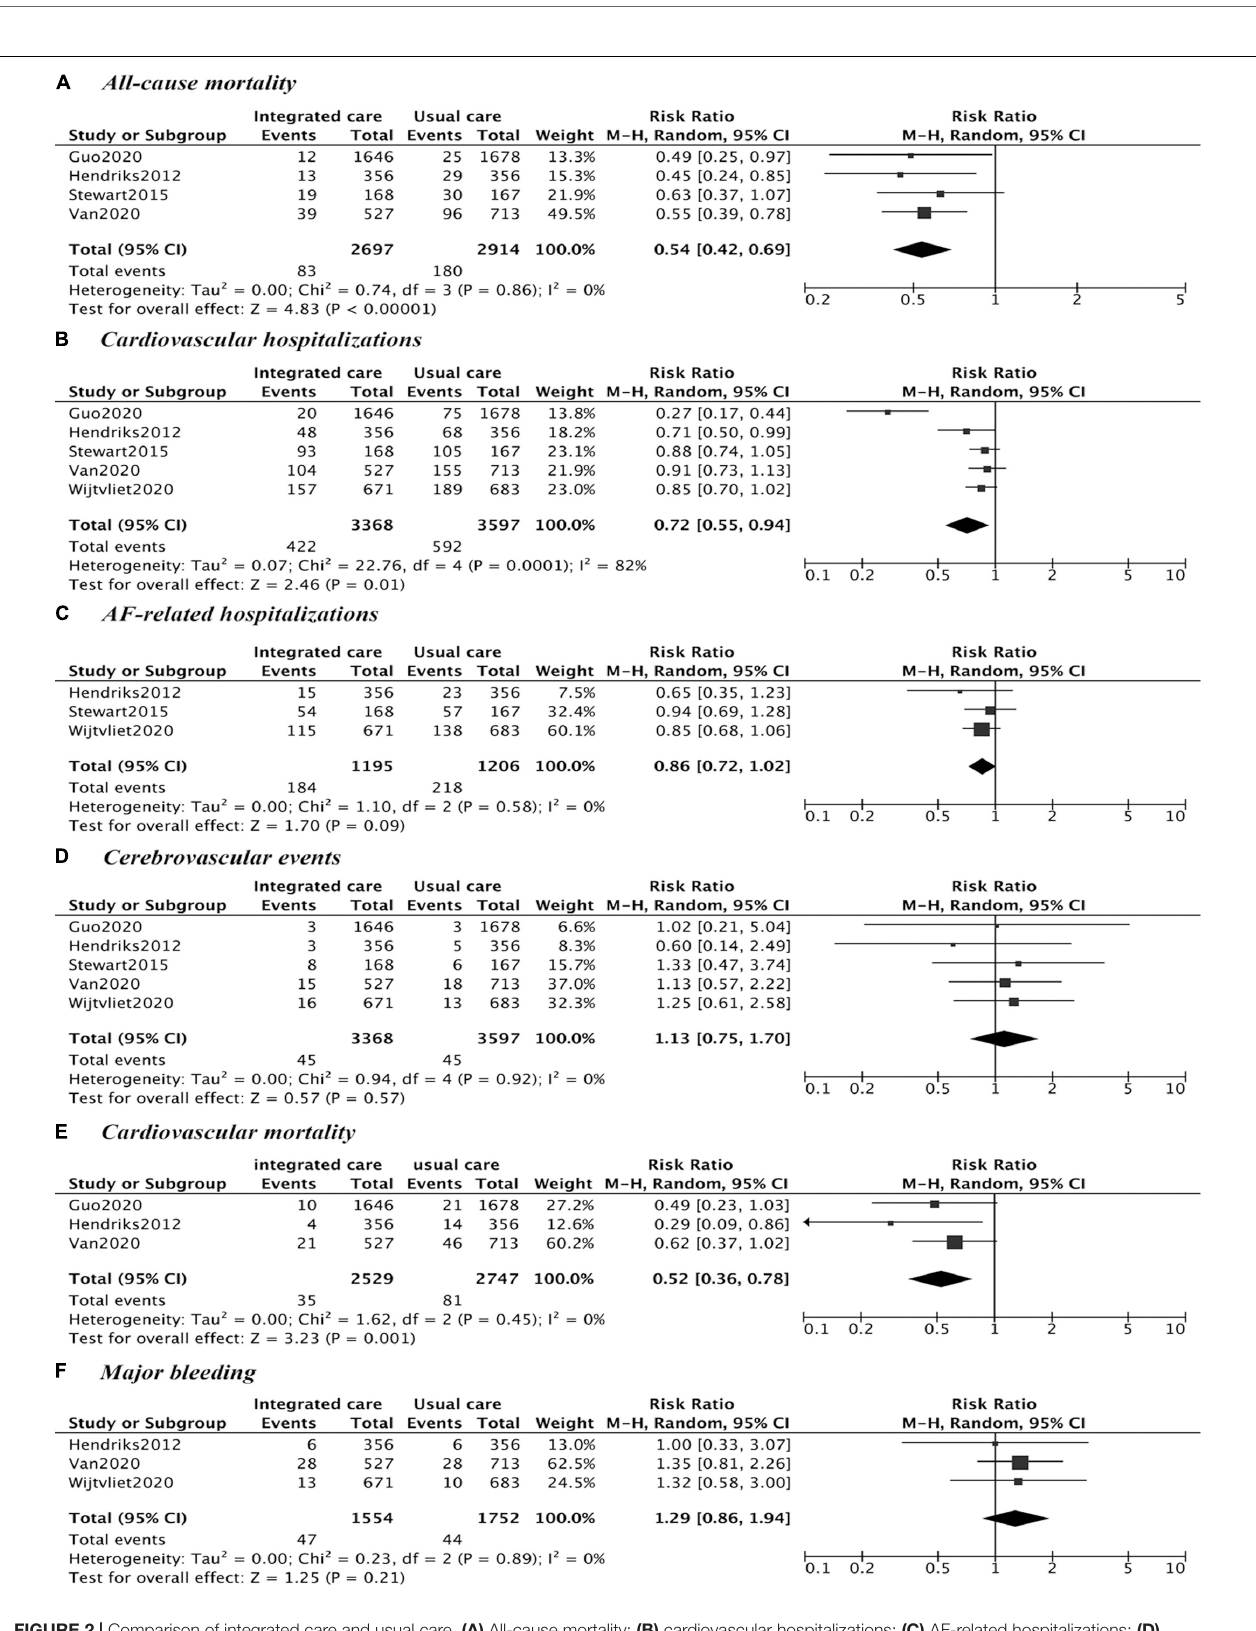
Frontiers in Cardiovascular Medicine |